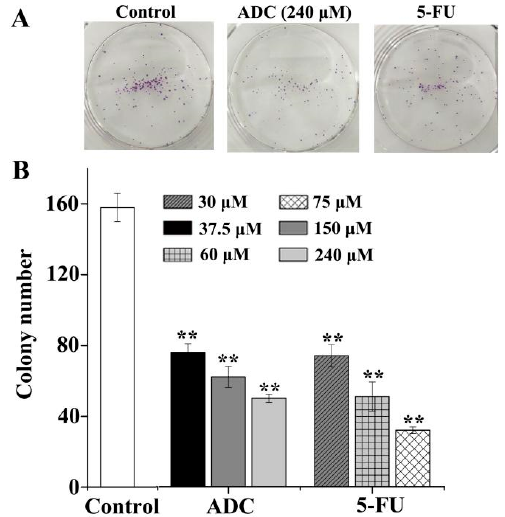
Figure 2. Colony formation assay. ( A ) ADC inhibited colony formation in SPCA-1 cells. After being treated with or without ADC, cells were seeded at 100 cells per plate and allowed to form colonies.